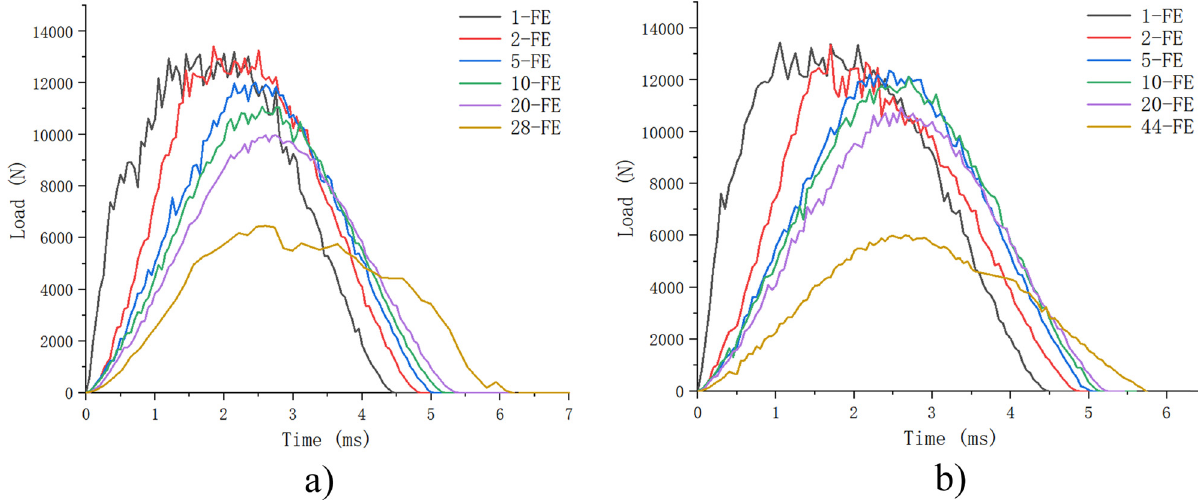
Figure 13: Finite - element simulation results: ( a ) multiple impacts with a braid angle of 15°, ( b ) multiple impacts with a braid angle of 30°, and ( c ) peak impact load comparison.